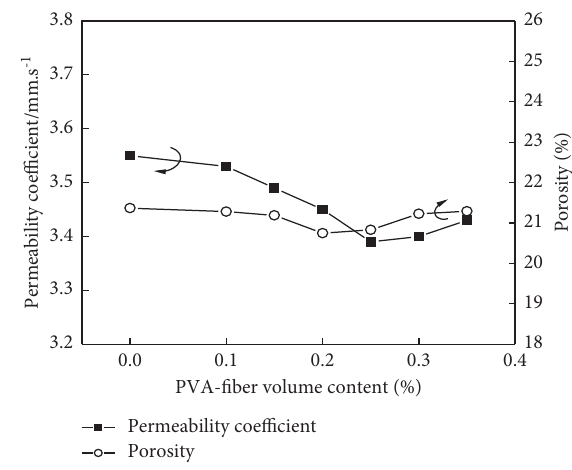
Figure 13: Relationships between porosity, permeability coeffi- cient, and PVA-fiber volume. Figure 11: Complete stress-strain curves of RCCA 40 , RCCA 40 F 1.5 ,